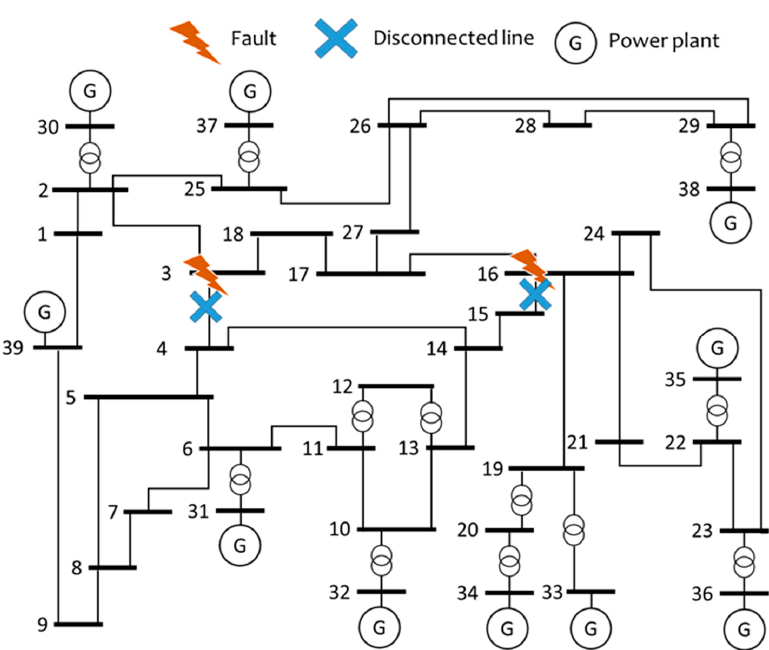
Figure 2. IEEE 39 Bus New England benchmark system with fault locations corresponding to the study in Section 4.